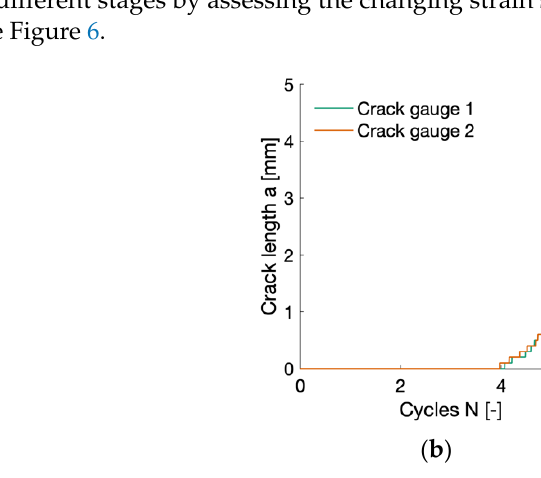
Figure 6. ( a ) Strain signal measurement of two crack gauges at top and bottom side over a number of cycles for a specimen of the series 15; ( b ) Crack lengths derived from strain signals.